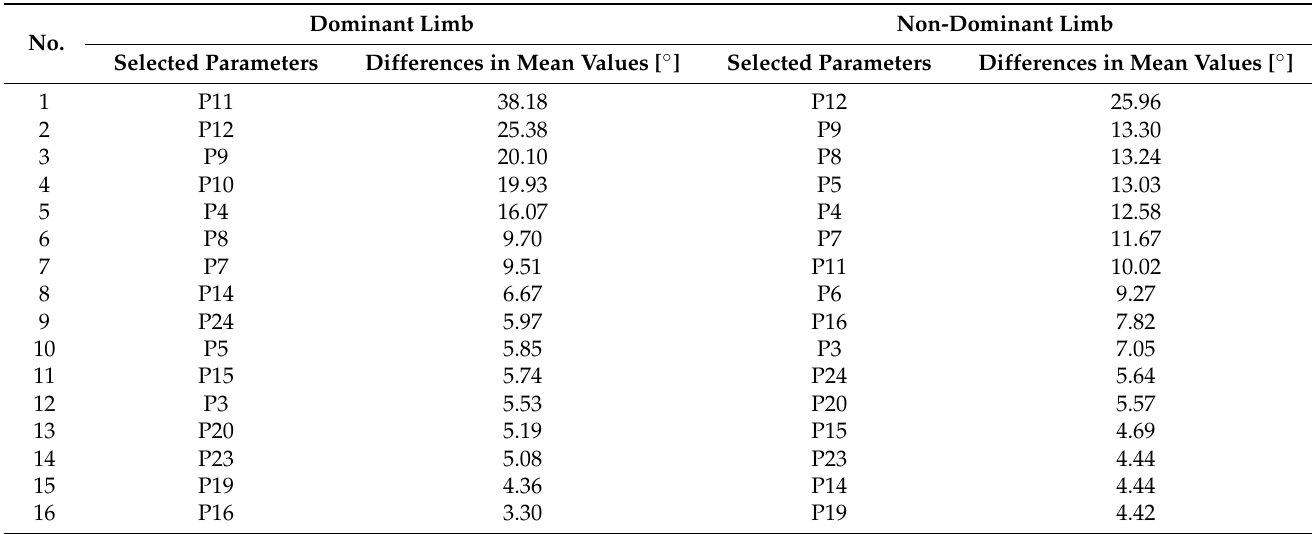
Table 5. Differences in mean values of parameters selected according to method M2.